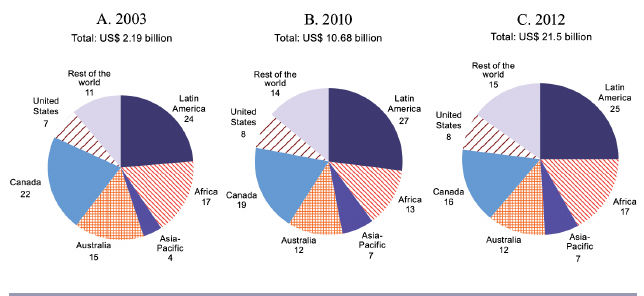
Fig. 2. Distribution (%) of world mineral exploration budget by region or country of destination (on the basis of Centre for Copper and Mining Studies/Metal Economics Group). Source: Economic Commission for Latin America and the Caribbean © 2013 United